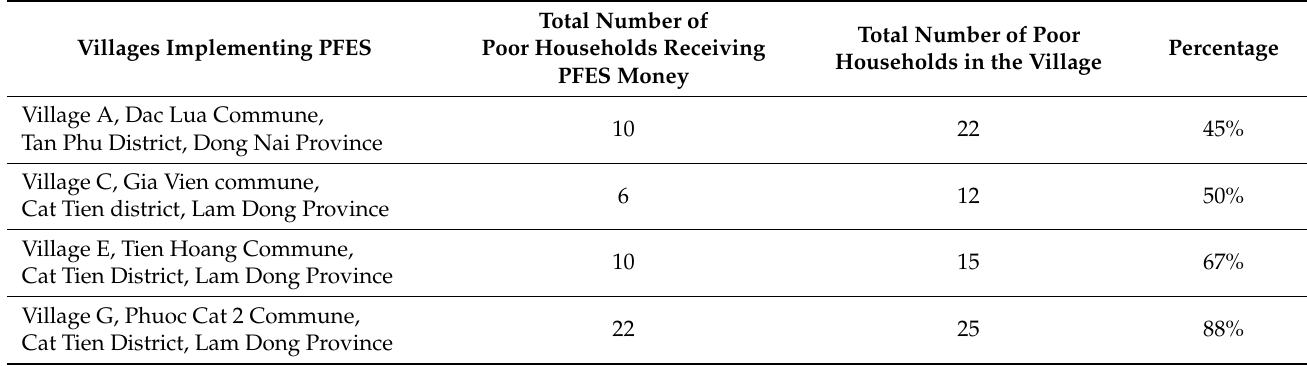
Table 6. Village-defined poor households receiving PFES